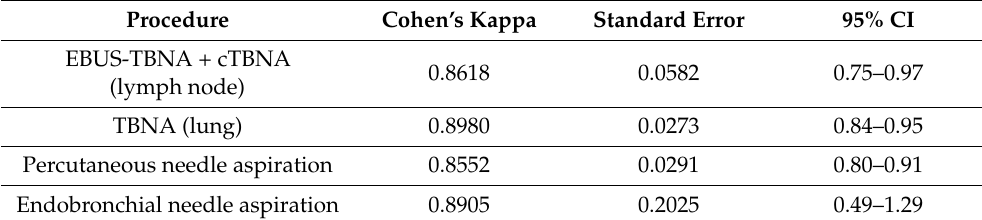
Table 4. Cohen’s kappa for “C1–C5 classification” concordance divided for procedures.